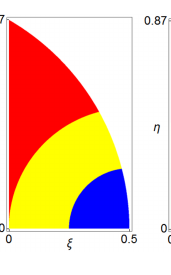
Fig. 2. Partitioning of the homology region D into three (left) and four (right) parts.